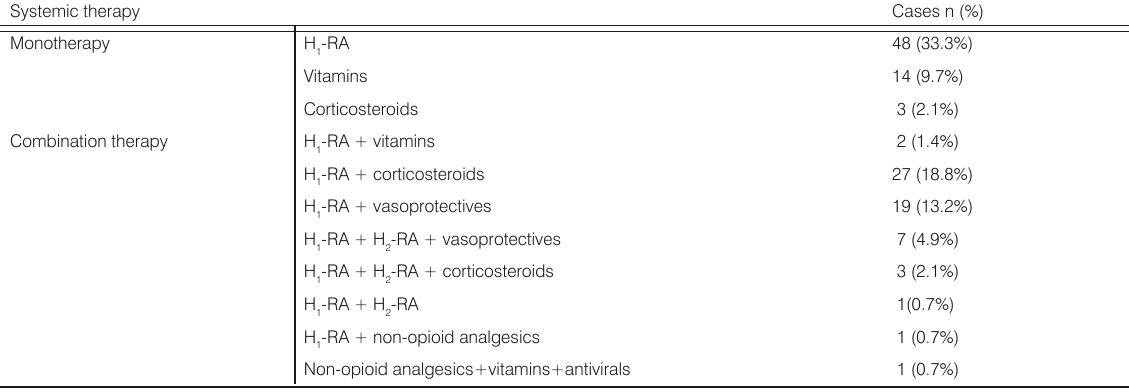
Table 3. Systemic therapy of ADRs.